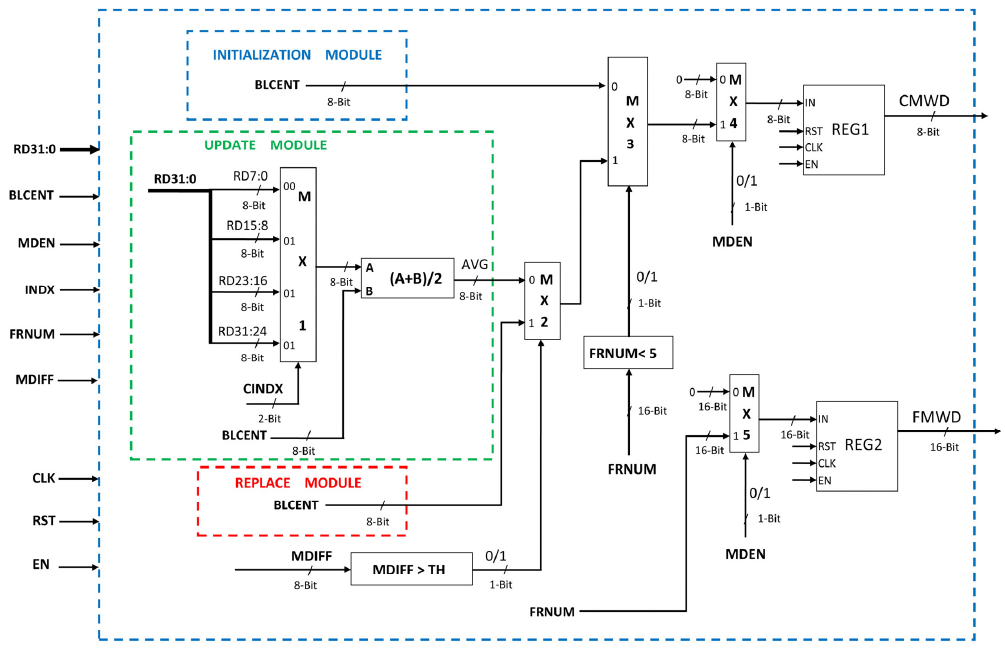
Figure 10. Proposed VLSI architecture of Initialization, Update, and Replace Module.